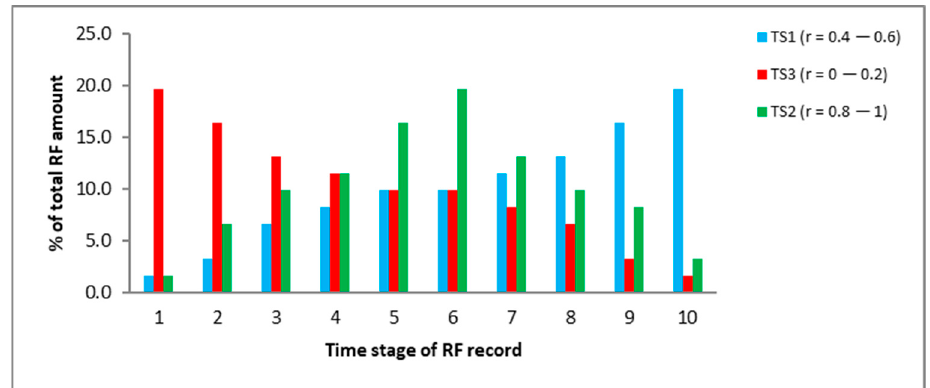
Figure 5. Rainfall patterns (TS1, TS2 and TS3) .